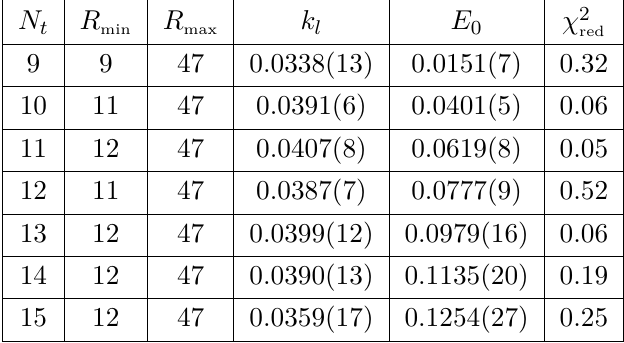
Table 9 . Best-fit estimates for E 0 for different values of N t at β = 13 . 42445